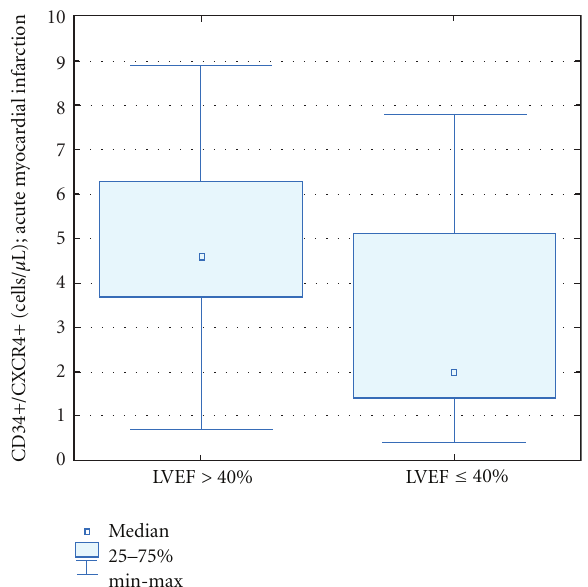
Figure 5: Mobilization of CD34+CXCR4+ cells in acute MI in patients who had preserved or reduced LVEF at 1-year followup post MI.